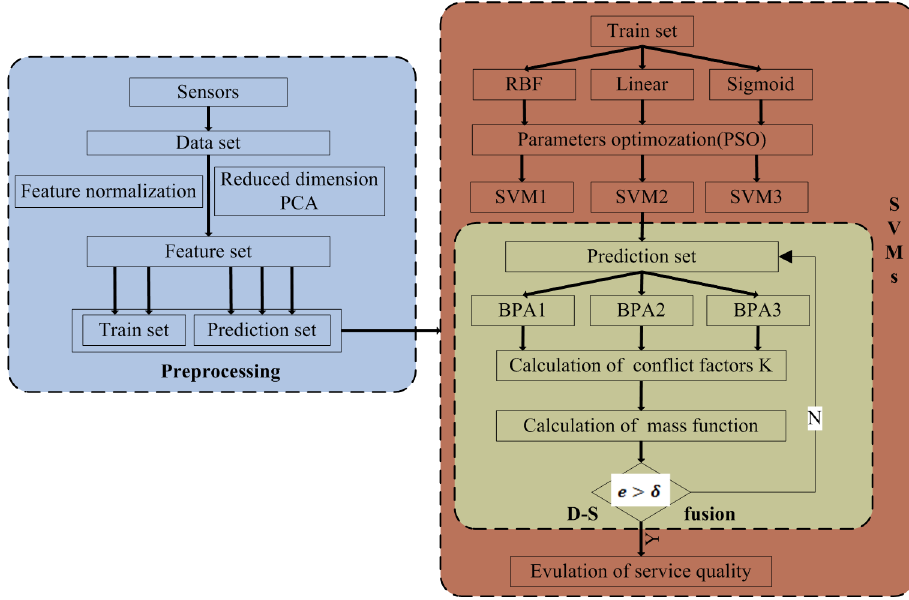
Fig 1. The proposed algorithm of